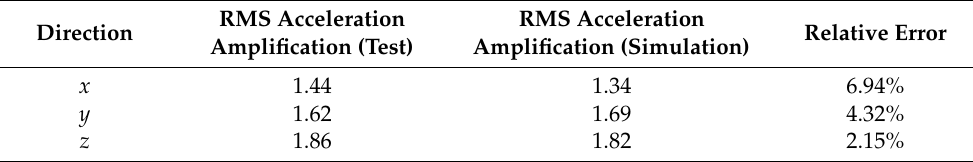
Table 6. Comparison between test and simulation of RMS acceleration amplification.